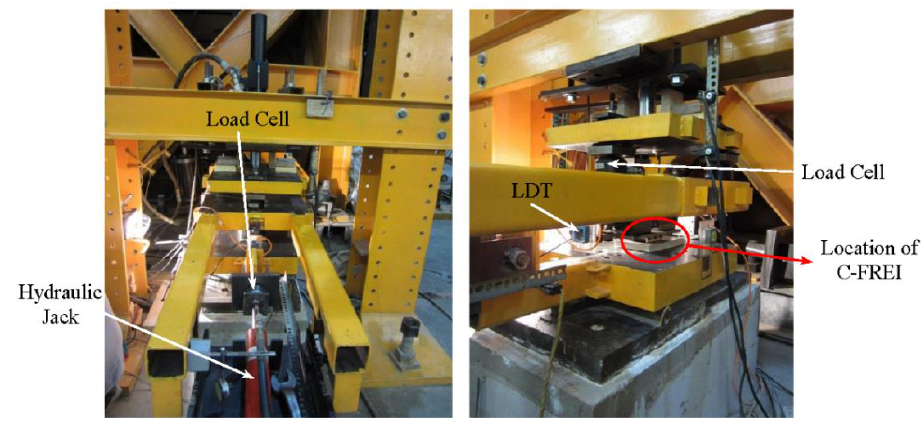
Figure 4. Test equipment used for testing C-FREIs.